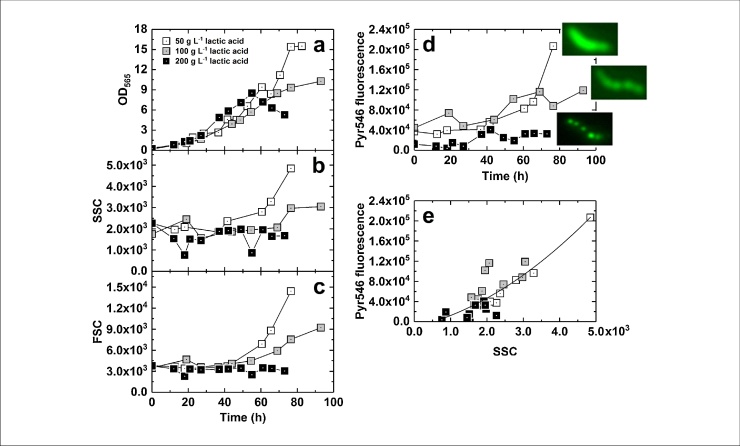
Flow cytometry analysis of scatter and PHA content of cells grown with different feed lactic acid (LA) concentrations. Samples taken from oxygen-limited pH-stat fermentations with different feed lactic acid concentrations were analyzed by measurement of OD565 and FCM. Twenty-five thousand data points were collected for each sample and mean values are represented. Panels show OD565 (a), forward scatter, FSC (b), side scatter, SSC (c), and fluorescence post-staining with Pyr546 (d) plotted against time; and Pyr546 fluorescence vs. SSC (e). The insets in (d) show fluorescence micrographs of cells at the end of each fermentation after staining with Pyr546.